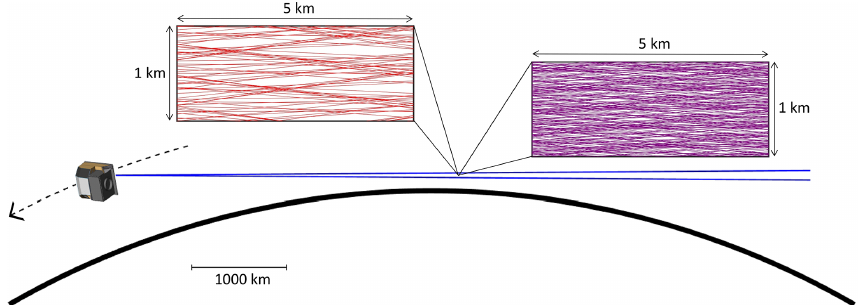
Figure 1. Illustration of the MATS limb observation geometry. From an orbit altitude of 585km, the vertical field of view of the limb instrument covers nominal tangent altitudes from 75 to 110km. The smaller inlays show examples of lines of sight filling a section of 5km × 1km in the orbit plane. The red lines in the left inlay are representative for the density of lines of sight through a given measurement volume, taking into account the larger binned image pixel size and the longer readout interval in an O 2 atmospheric band channel. The violet lines in the right inlay are representative for the density of lines of sight through a given measurement volume, taking into account the smaller binned image pixel size and the shorter readout interval in an NLC